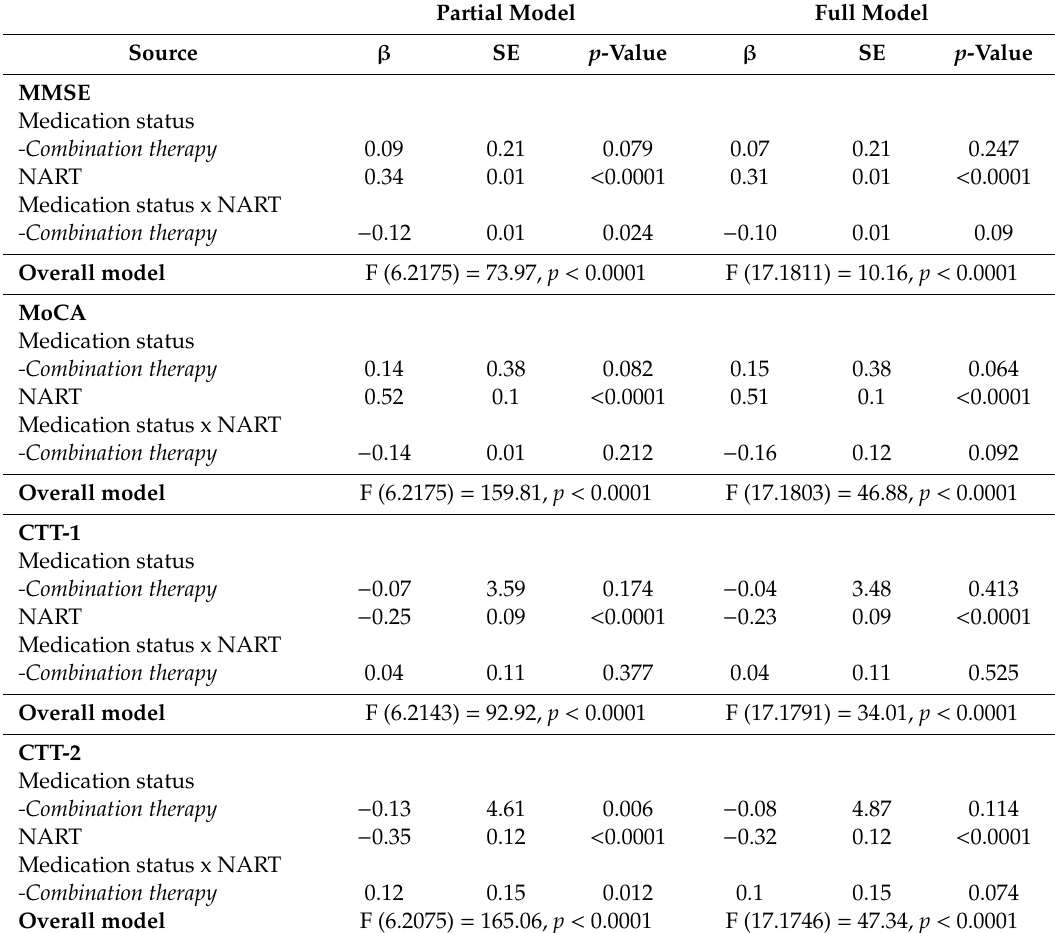
Table8. Multivariateregressionresultsofthee ff ectsofmedicationstatusondi ff